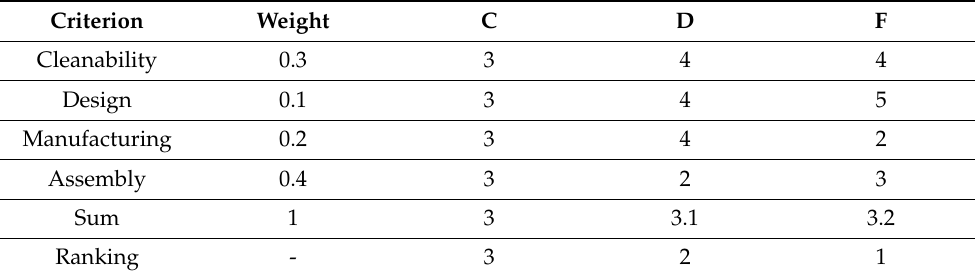
Table 6. Quantitative evaluation of the three concepts with the highest scores in Table